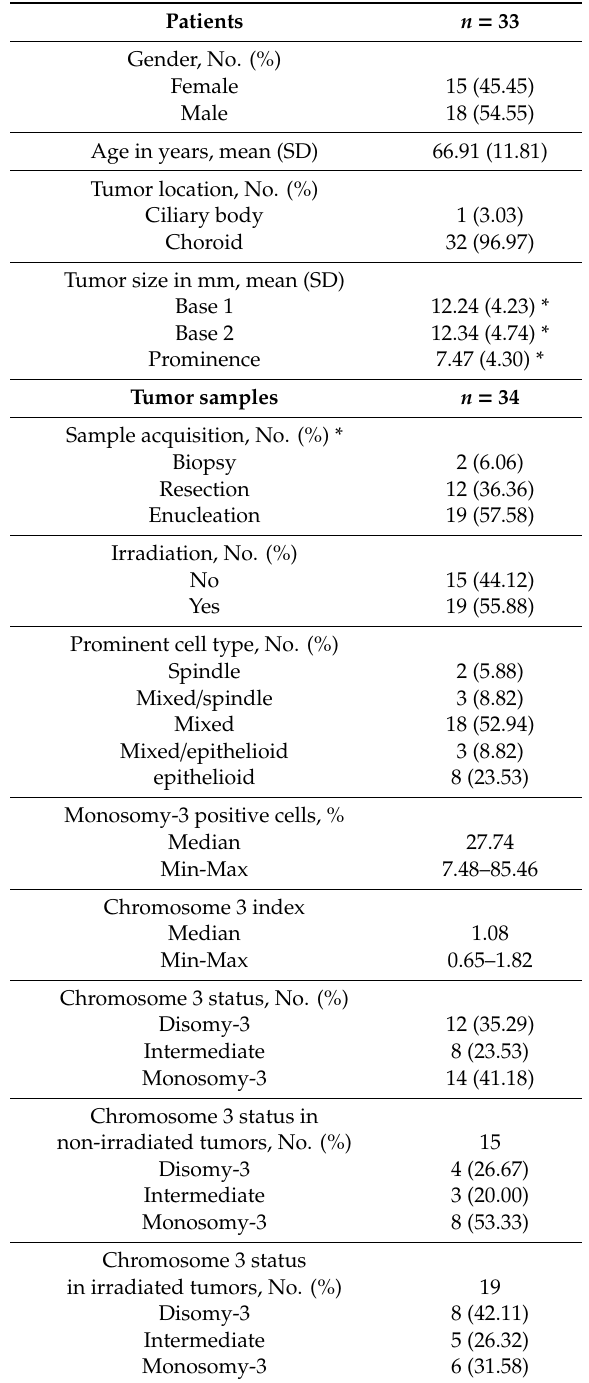
Table 1. Baseline characteristics of the patients and tumor